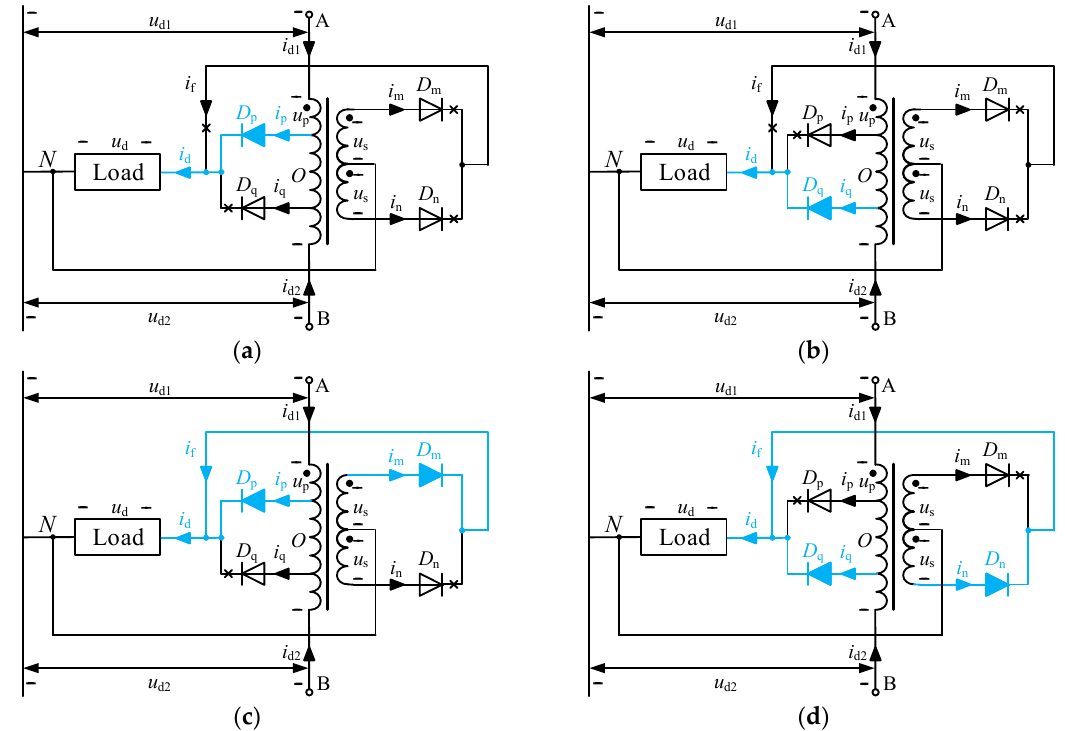
Figure 4. Operation modes of the unconventional IPR. ( a ) Operation mode I; ( b ) Operation mode II; ( c ) Operation mode III; ( d ) Operation mode IV.